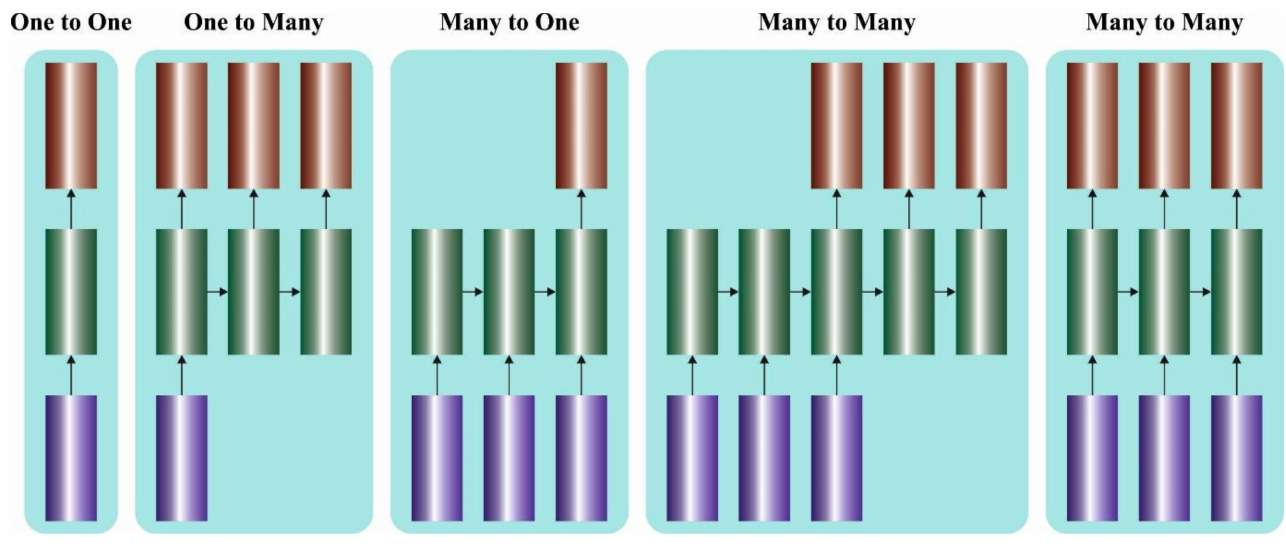
Figure 1. Structure of